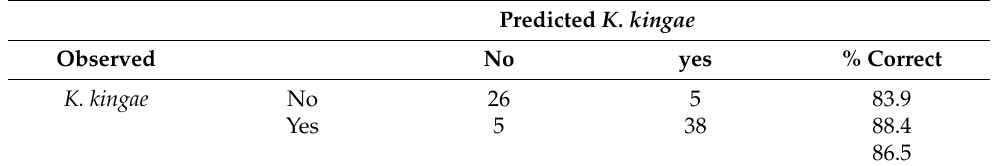
Table 2. Predicted model to distinguish K. kingae and typical arthritis pathogens in children < 5 years *.